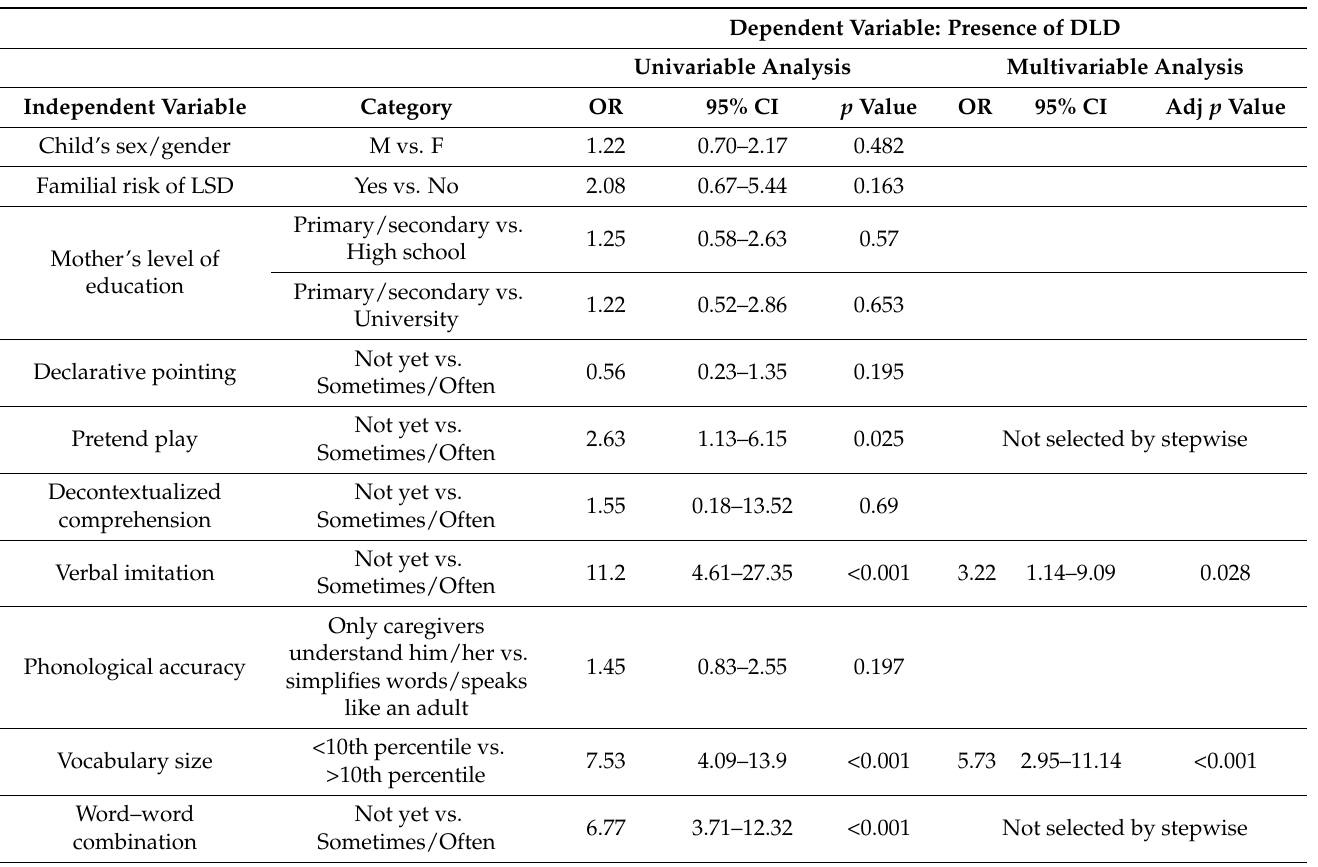
Table 4. Details of the univariable analyses and the best multivariable model with diagnosis of DLD as the dependent variable.